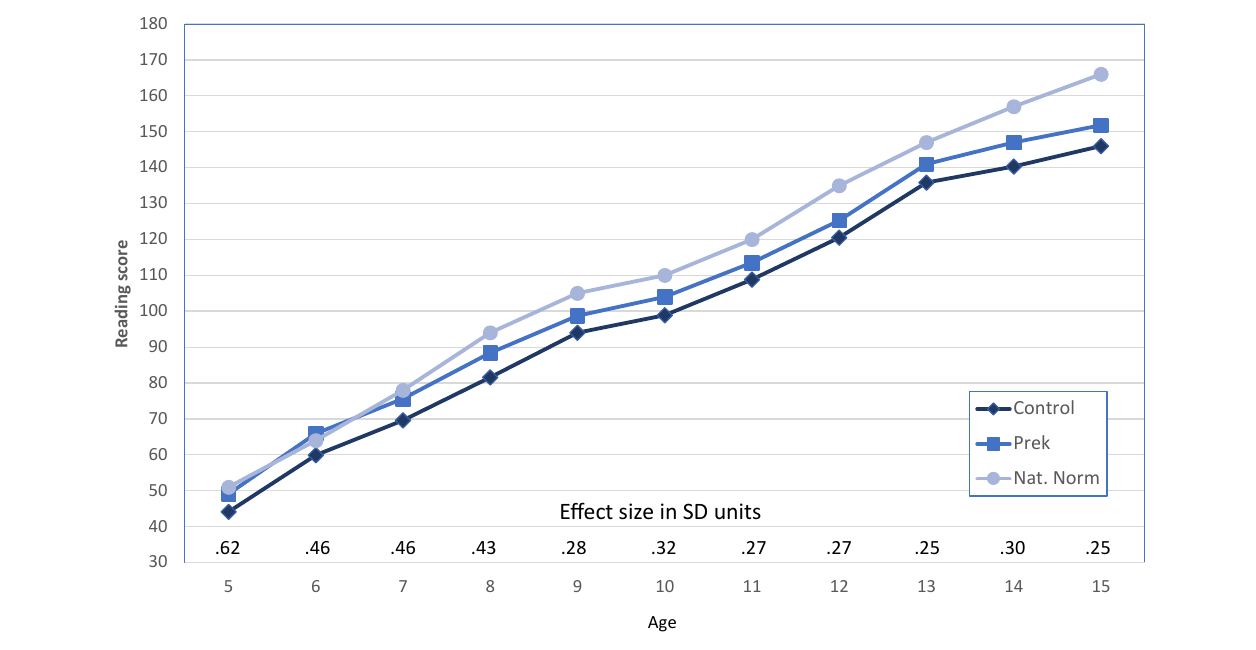
FIGURE 3 | Reading achievement for Child Parent Center (CPC) participants (with at least preschool) and others at ages 5–15. Reading test scores from Iowa Test of Basic Skills for CPC preschool program participants, non-CPC participants serving as controls, and national